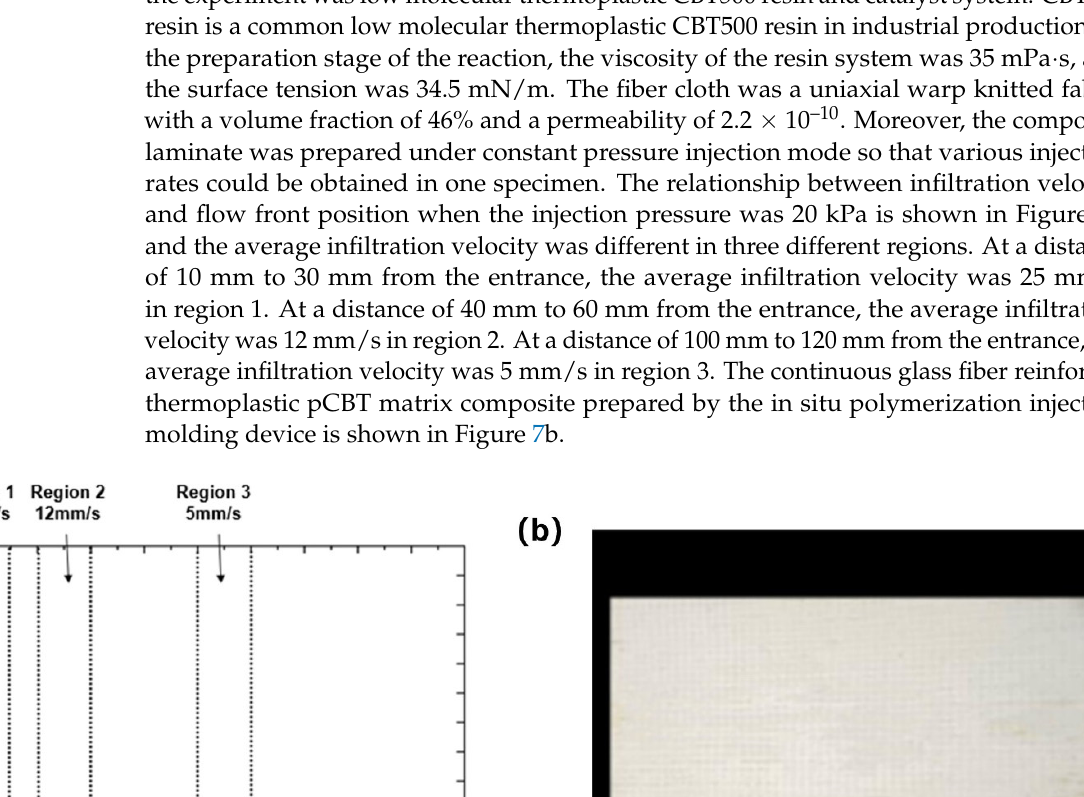
Figure 6. ( a ) Schematic diagram of in situ polymerization injection molding device. ( b ) Physical drawing of in situ polymerization injection molding device.